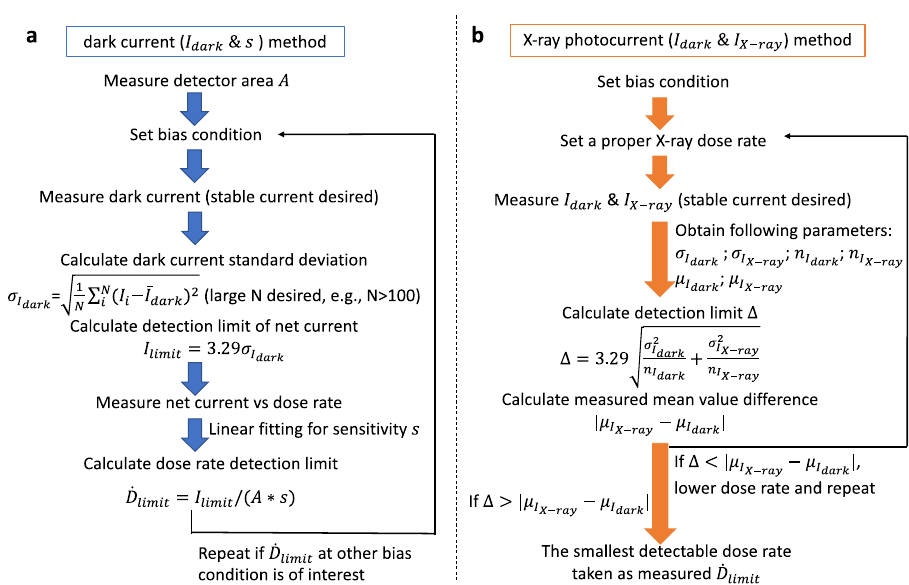
Fig. 5 A practical procedure for detection limit determination. a The dark current I dark & s method. N is the number of digitized current points of dark current and I i is the i th point. b The X-ray photocurrent I dark & I X – ray method. σ I n n I X (cid:3) ray and I dark are the number of digitized current points of